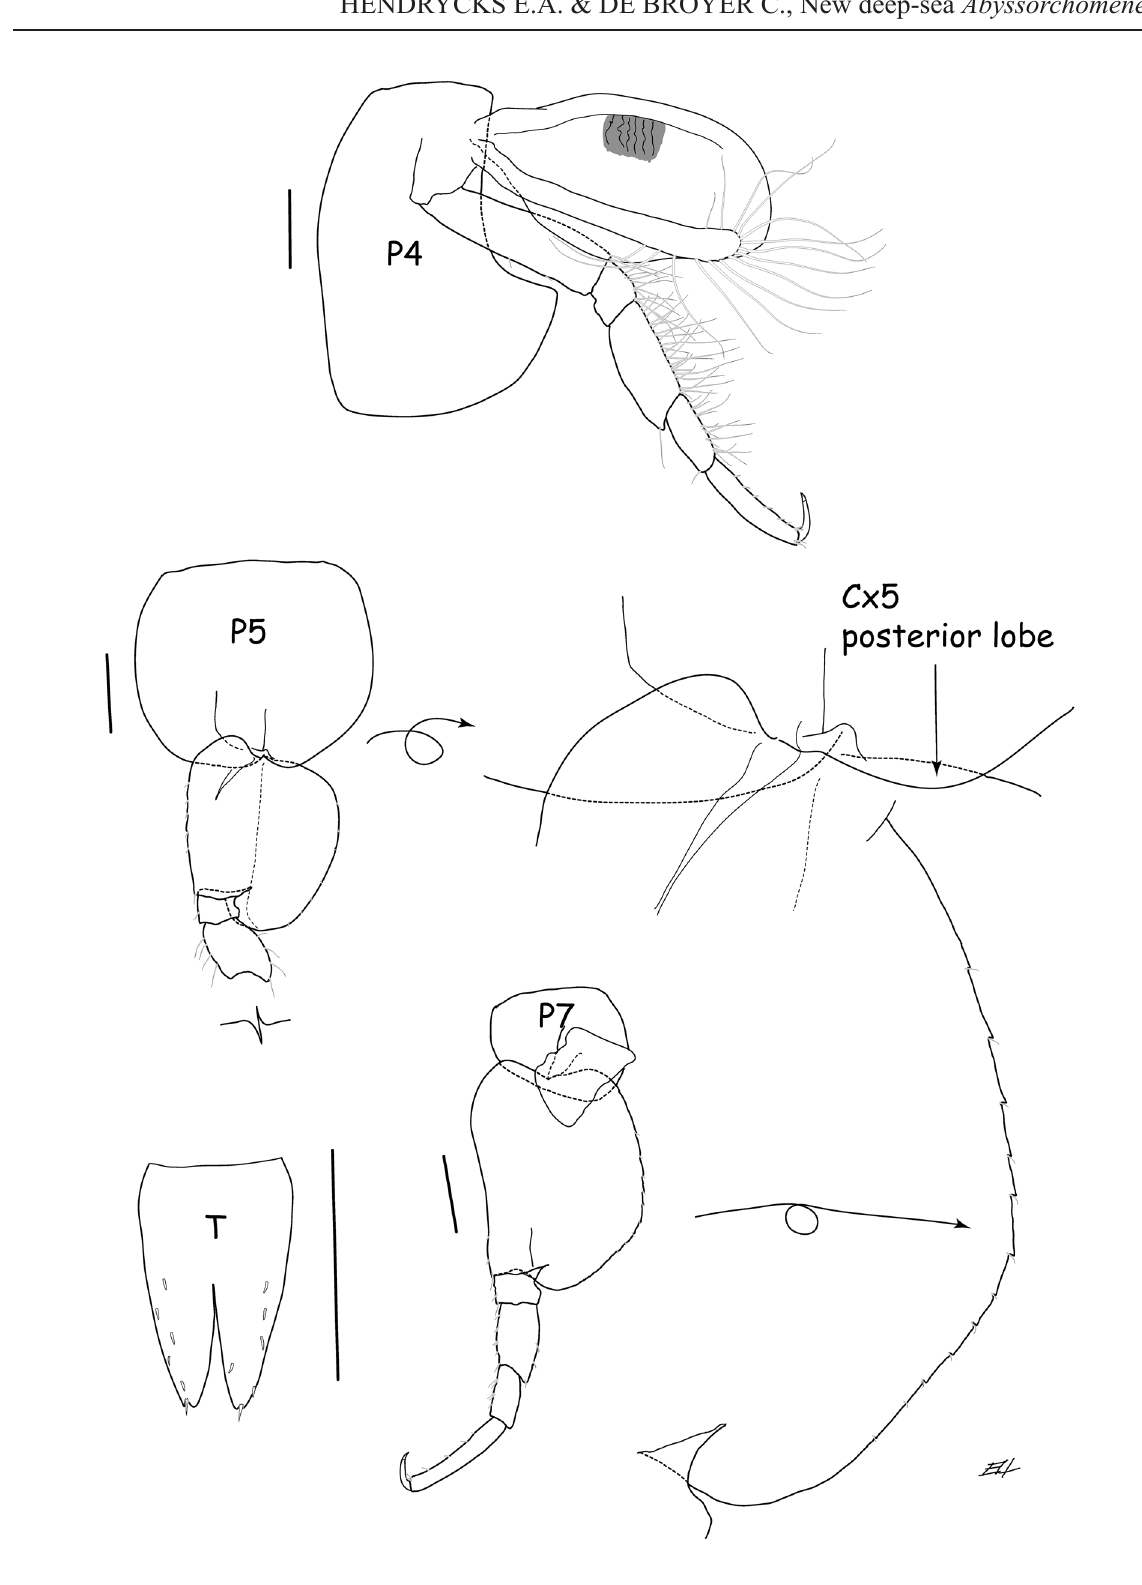
Fig. 4. Abyssorchomene abyssorum (Stebbing, 1888), ♀, 9.5 mm (ZMH K-61206). Scale bars = 0.5